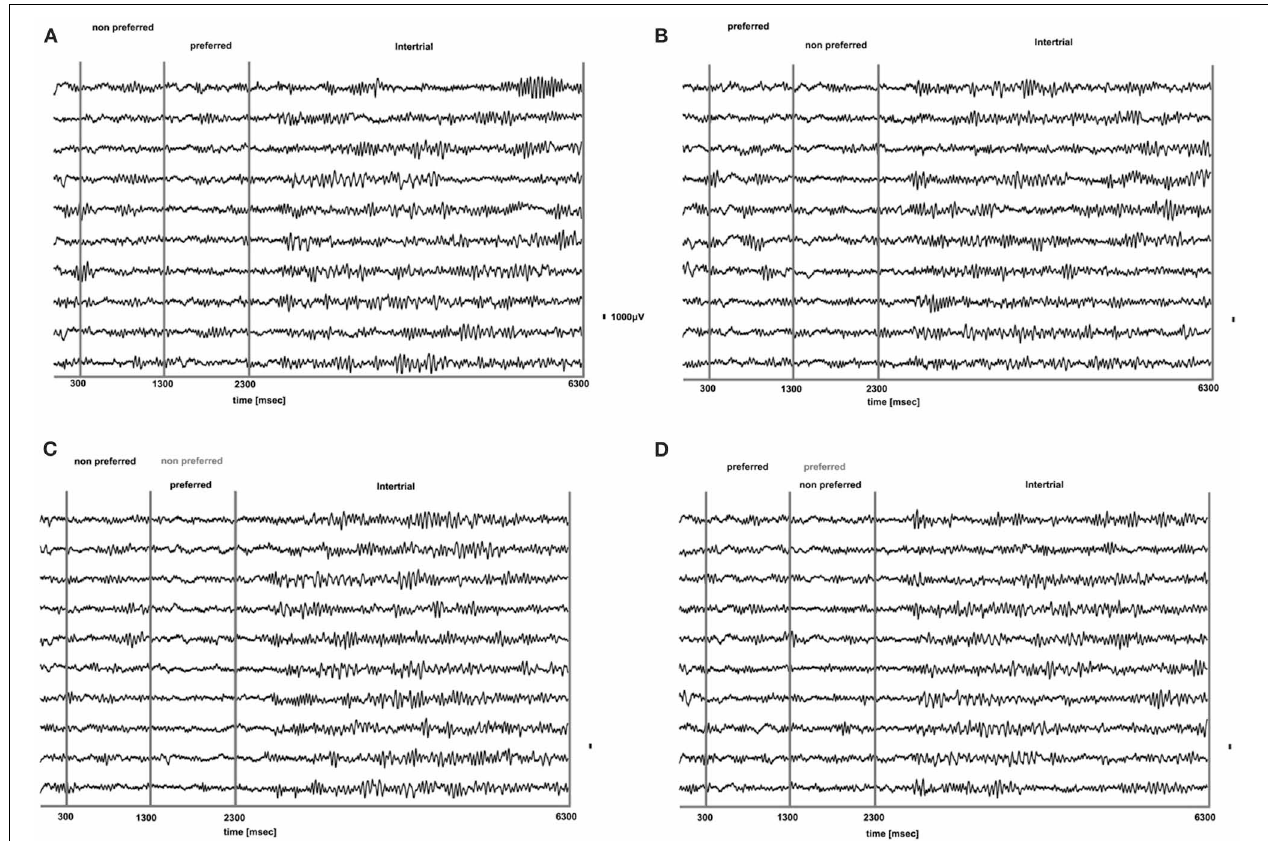
FIGURE 3 | Raw LFP traces (1–475Hz) during PA (A,B) and BFS (C,D) for 10 trials from a typical prefrontal recording site. In (A) , a non-preferred stimulus is presented in one eye and after 1s is removed and a disparate pattern is presented in the contralateral eye. Using as a criterion the discharge response of the locally recorded population we determined that the second stimulus was the “preferred.” In (B) the order of visual stimulation is reversed and the preferred stimulus is followed by the presentation of the non-preferred. In (C,D) for BFS the order of stimulation is the same as in